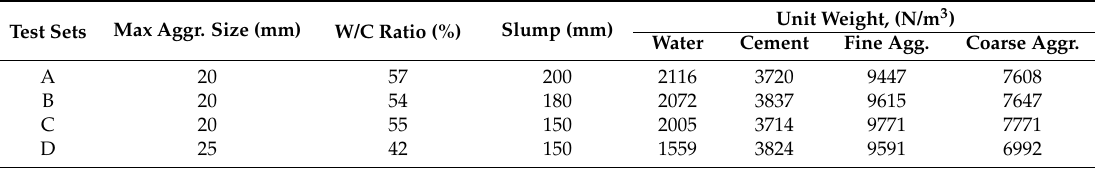
Table 1. Concrete mix proportions for the four sets of